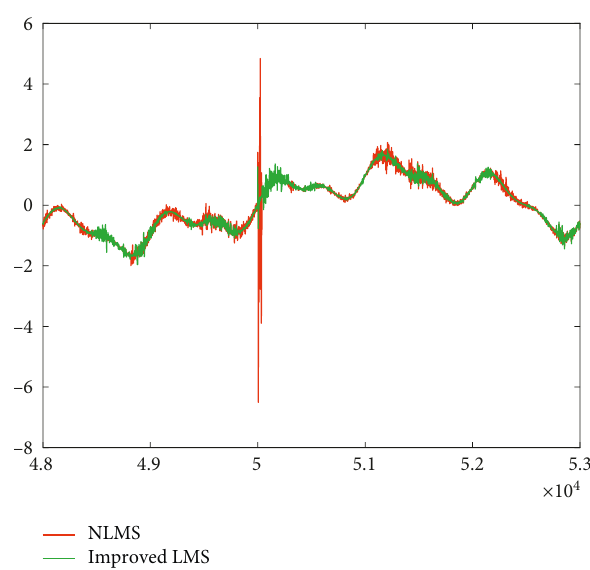
Figure 8: Local comparison of the NLMS algorithm and improved n of the NLMS ( ) LMS